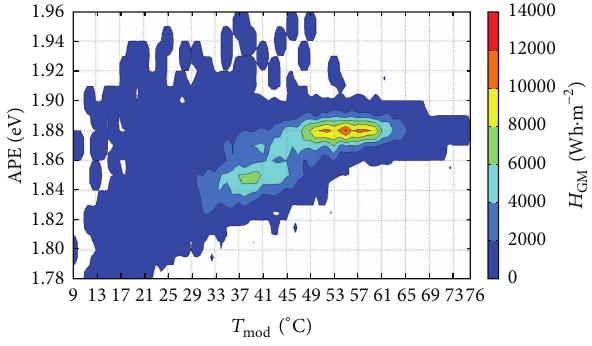
Figure 3: Contour graph of 𝐻 campaign (November 2011–October 2012, inclusive) as a function of 𝑇 mod and APE for the tested a-Si:H module. Blank areas indicate no data